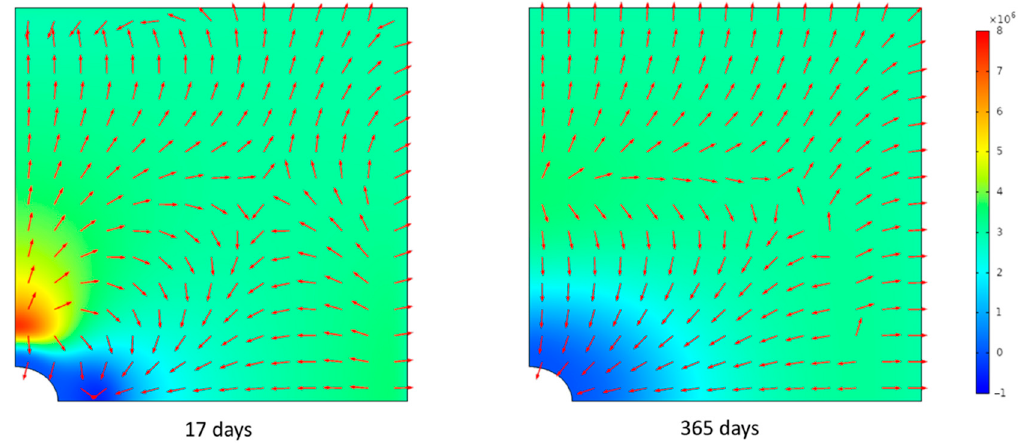
Figure 16. Simulated pore pressure distribution and groundwater velocity field.